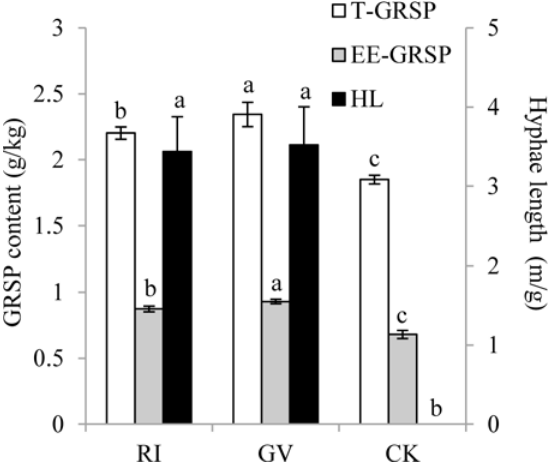
Fig 2. GRSP content and hyphae length in rhizosphere of R . pseudoacacia colonized by R . irregularis (RI), G . versiforme (GV) or not (CV). Significant differences are indicated by different letters (one-way ANOVA with Fisher ’ s LSD; P = 0.05; n = 6). EE-GRSP, easily extractable glomalin-related soil protein; T-GRSP, total glomalin-related soil protein; HL, hyphae length. Replicate data is from S1